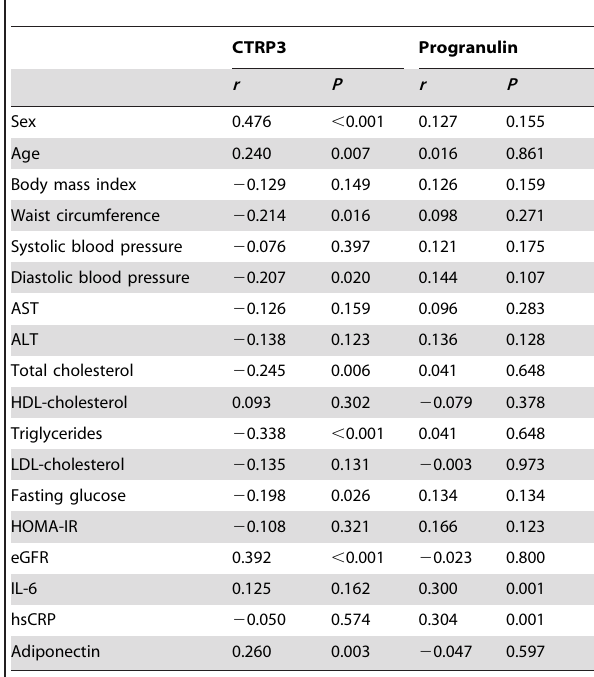
Table 2. Spearman Correlation of Serum Progranulin and CTRP3 with Various Metabolic